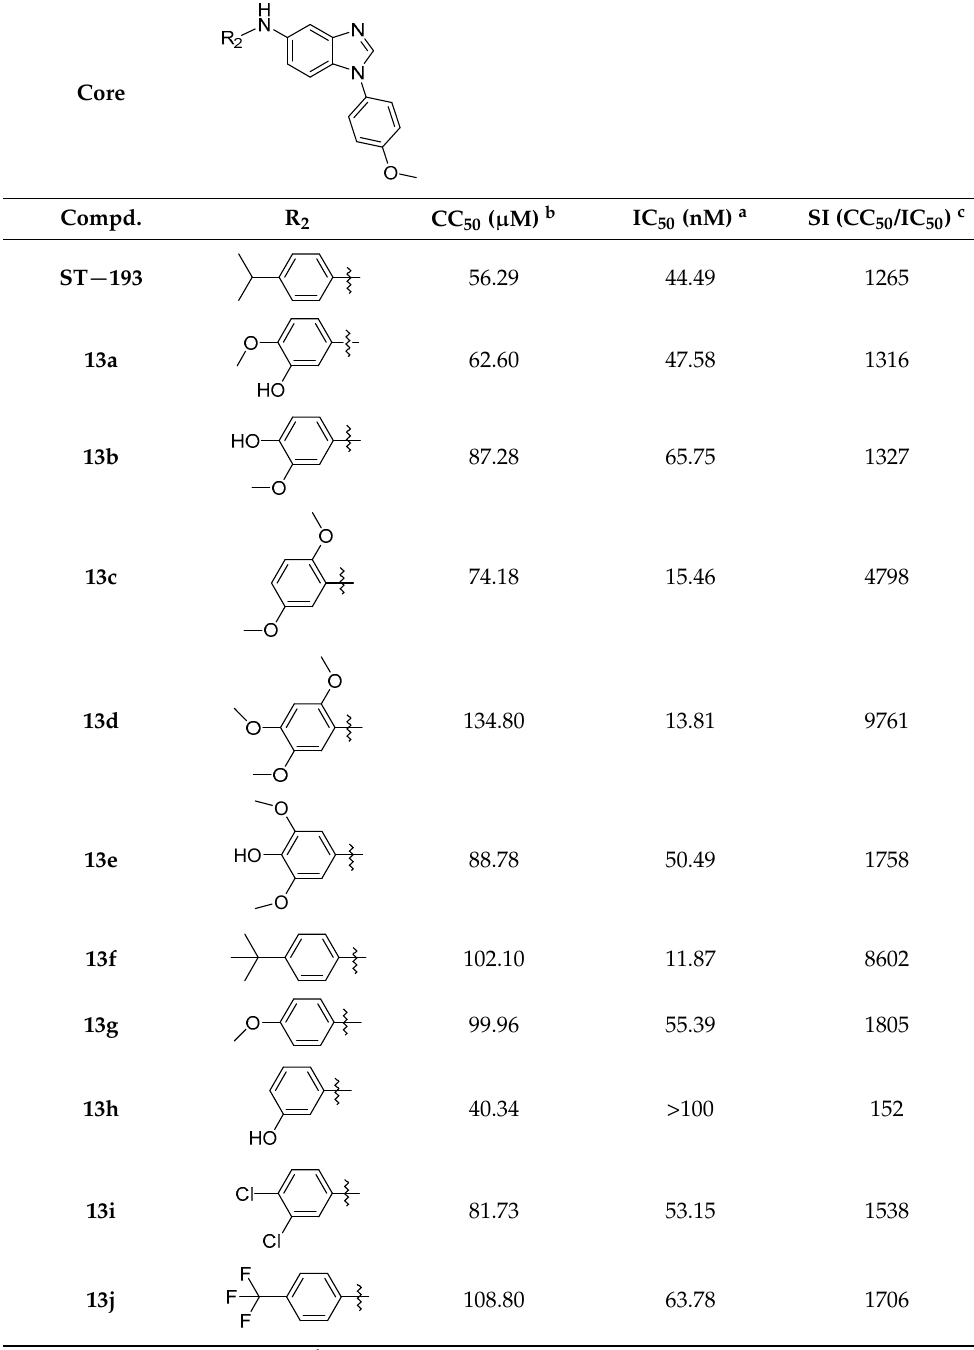
Table 2. Inhibition of LASVpv pseudotyped viruses by synthetic compounds 13a − 13j .